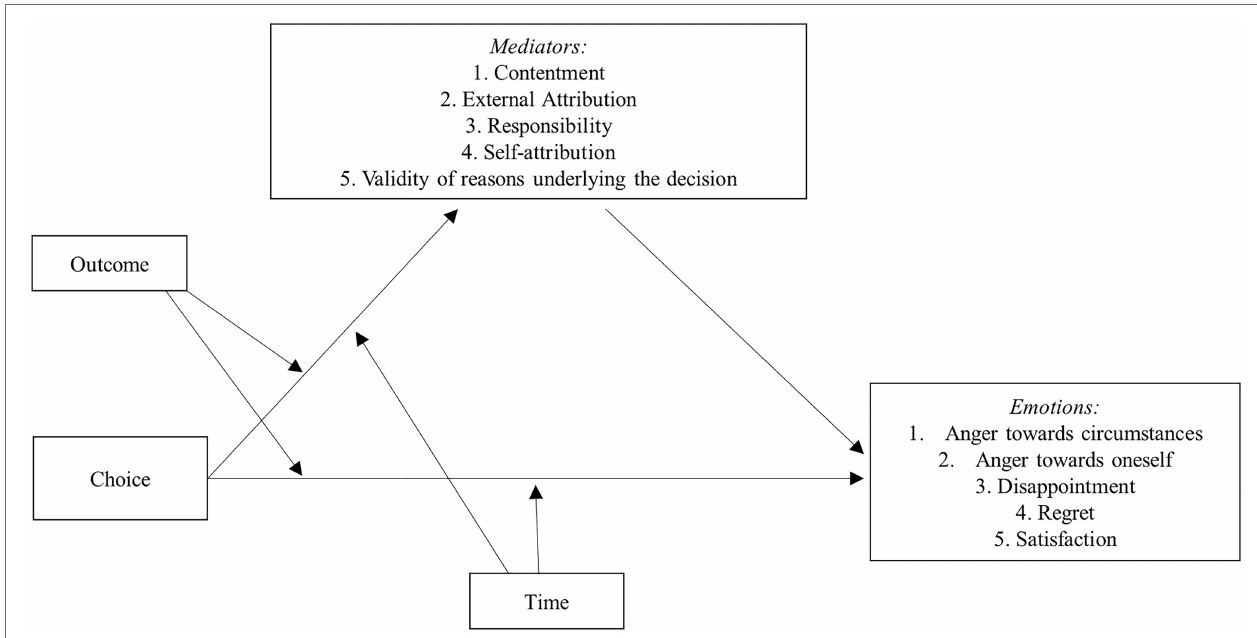
FIGURE 1 | Model 10 of PROCESS